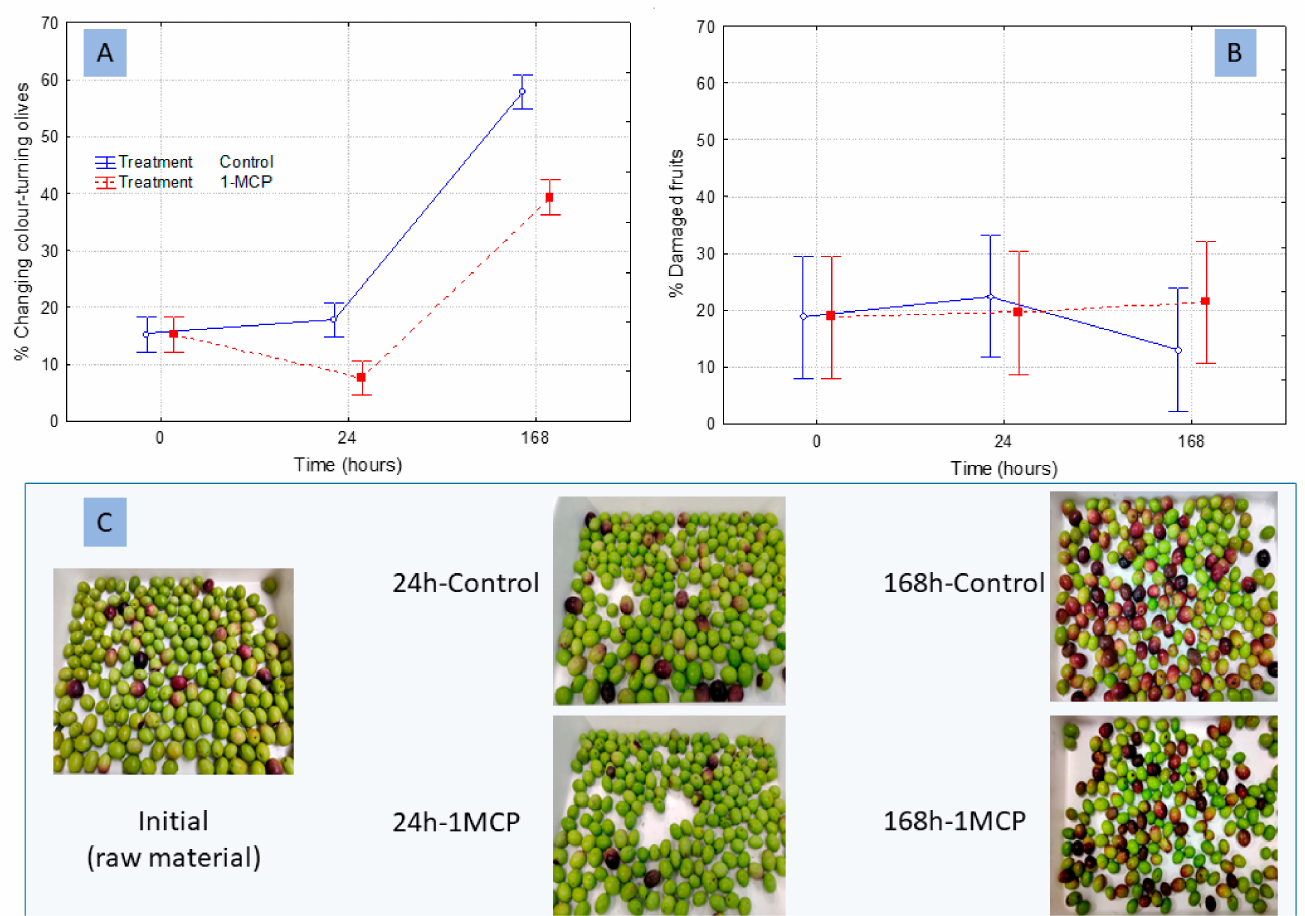
Figure 1. Evolution of the percentage of colour-turning olives ( A ) and damaged fruits ( B ), determined by a panel of experts ( n = 4), as well as fruit appearance ( C ) for the control and 1-MCP treated fruits during the first 168 h after harvesting. Time 0 corresponds to the moment just after picking and before 1-MCP treatment. Non-overlapping error bars stand for significant differences among treatments according to ANOVA analysis and post hoc statistical LSD test using p ≤ 0.05 as the cut-off level of significance.